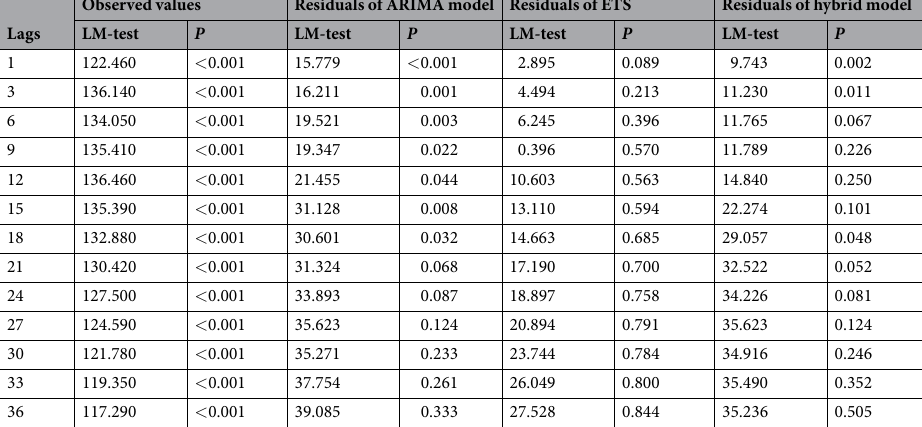
Table 2. LM-test of the residuals for each of the selected optimal